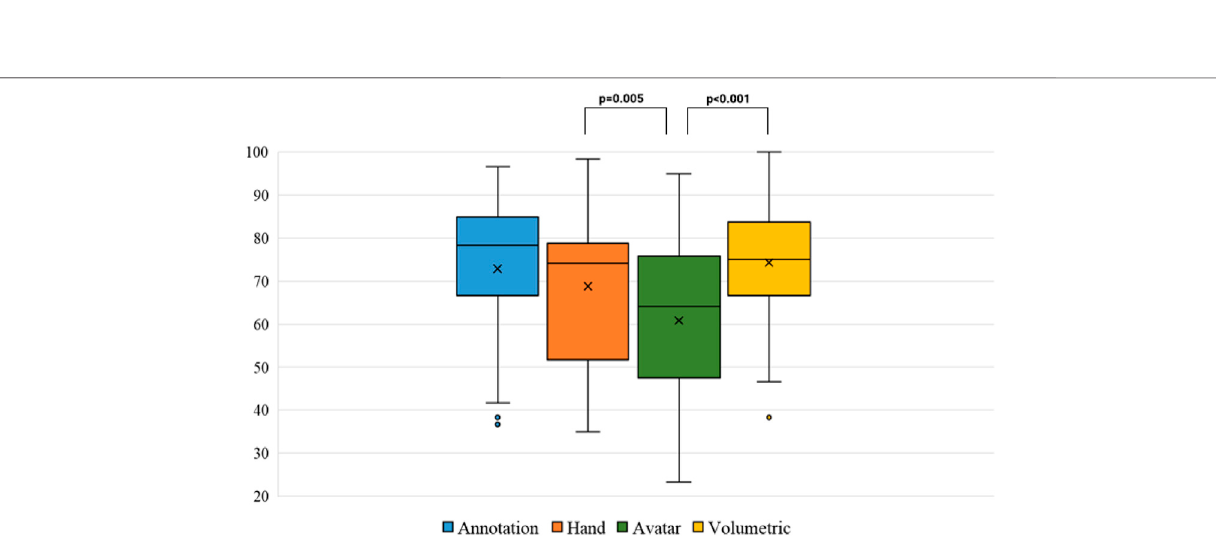
FIGURE 8 | User preference based ranking results (Rank1 is the most